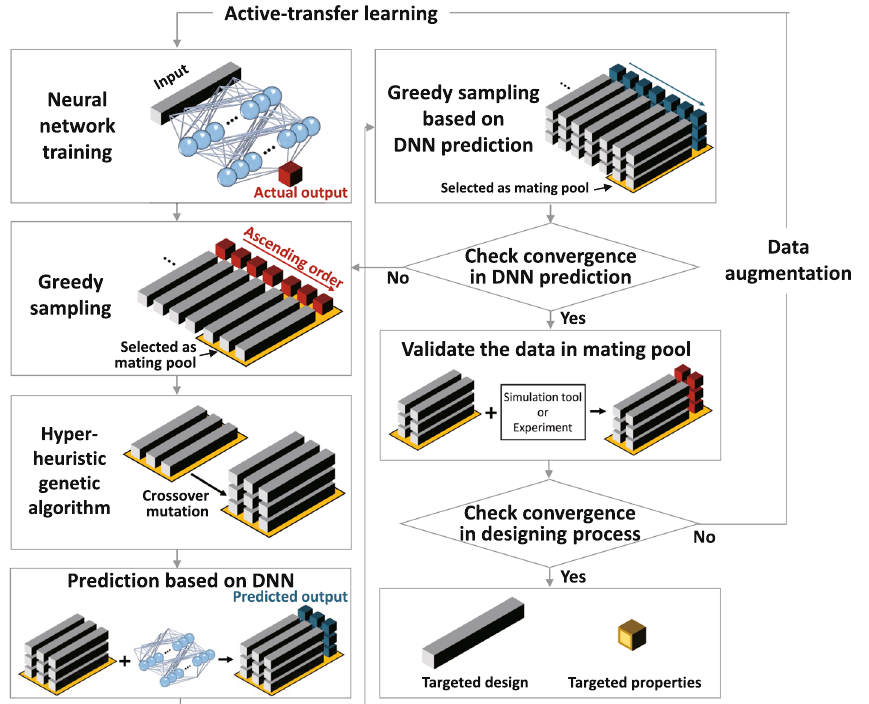
Fig. 4 Flowchart of design framework. Flowchart of the hyper-heuristic genetic optimization algorithm based on active transfer